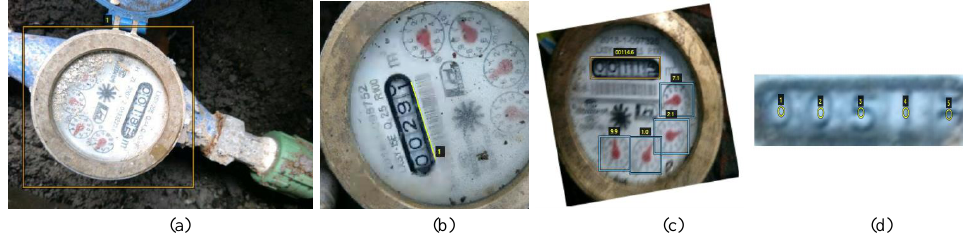
Figure 8. Examples of data annotations required to train different models. ( a ) annotates the position of the water meter, ( b ) annotates the direction of watermeter, ( c ) annotates the position and value of the inner components, and ( d ) annotates the digit box’s center